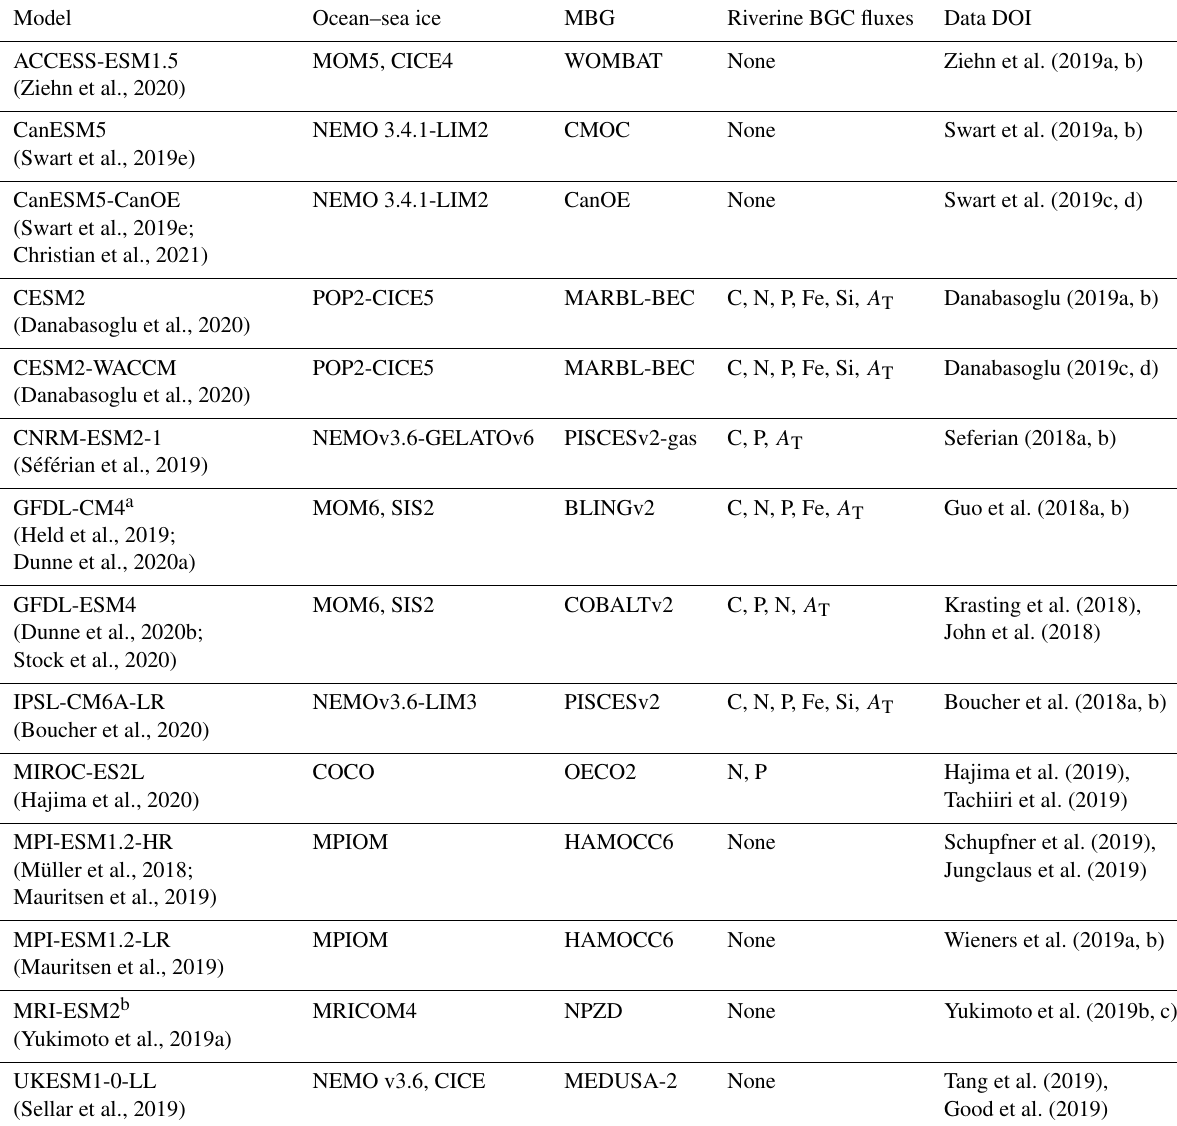
Table 1. The CMIP6 ESMs used in this study with their ocean–sea ice and marine-biogeochemical (MBG) model components plus their biogeochemical (BGC) riverine